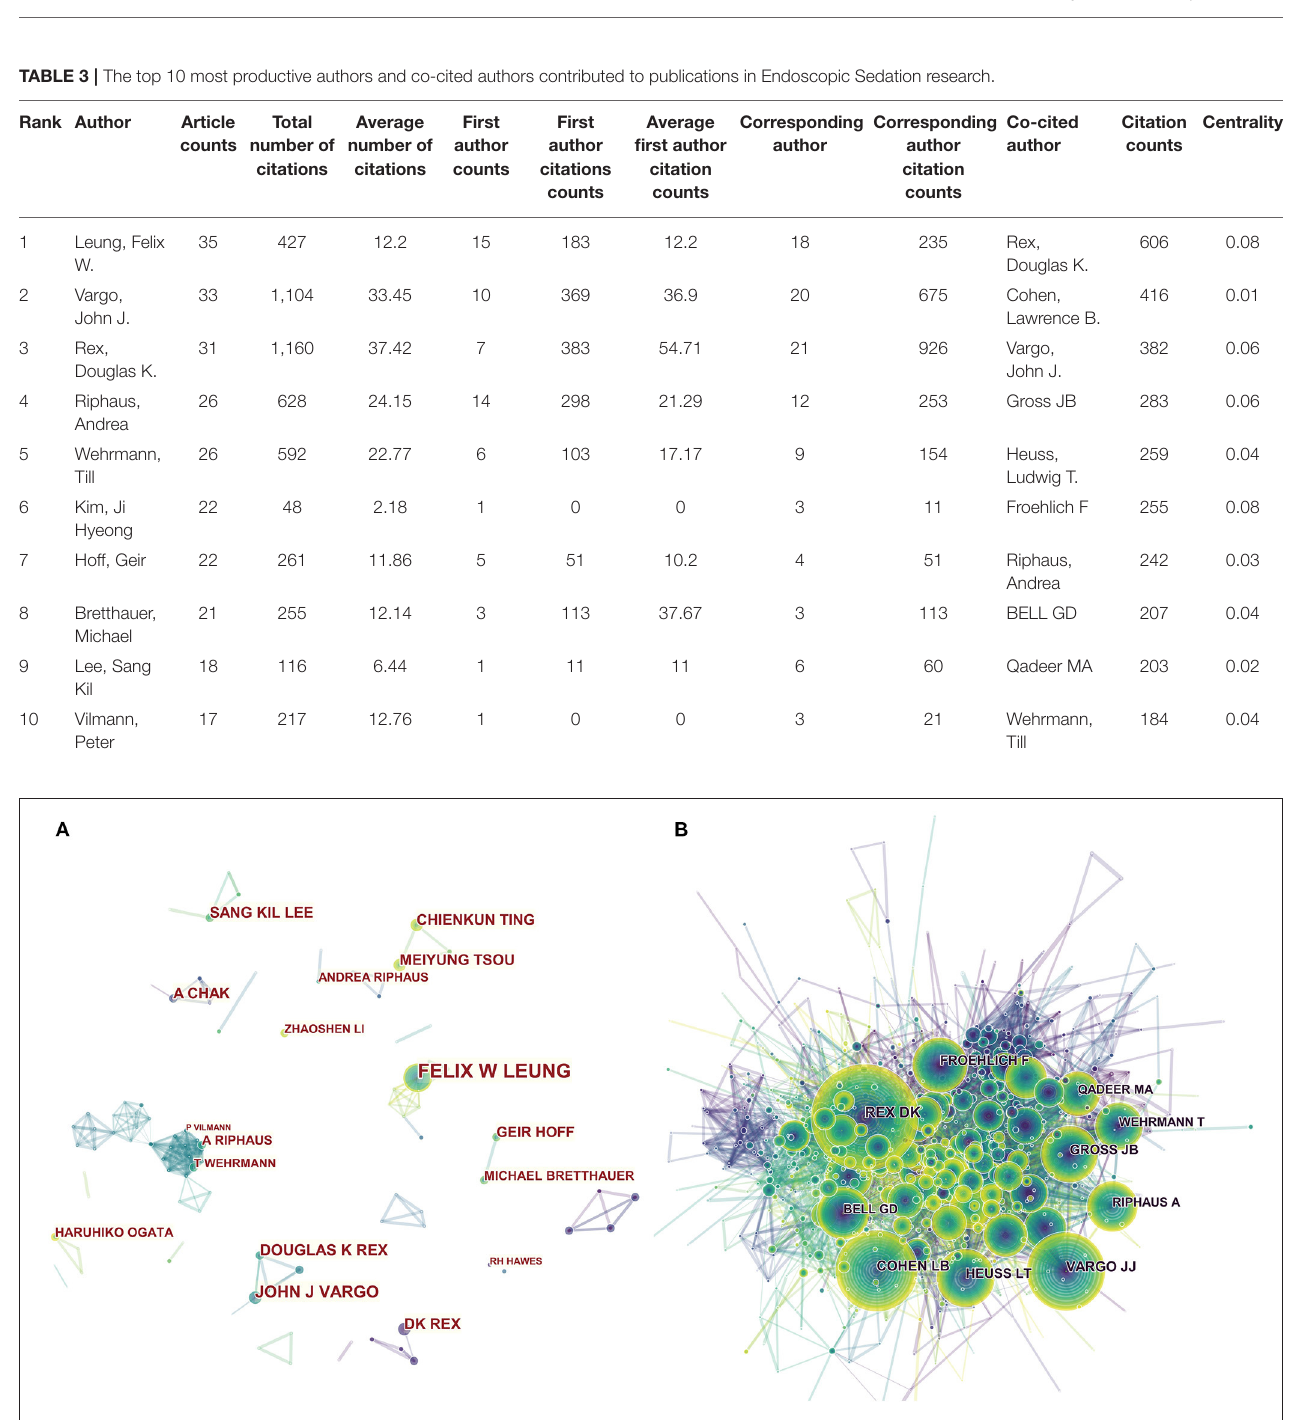
references were clustered into 19 major cluster labels: propofol, colon capsule endoscopy, tolerance, water exchange (WE), endoscopic ultrasonography, sedationless, randomized clinical trial, nursing shortage, training, carbon dioxide insufflation, colorectal cancer, ketamine, local anesthesia, anxiety,